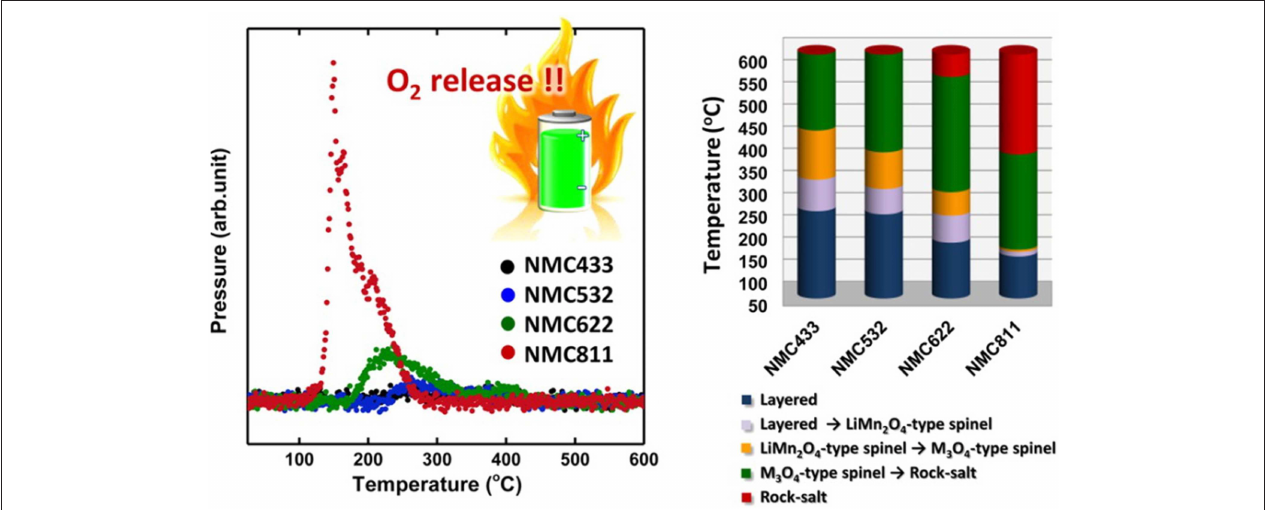
FIGURE 6 | Mass spectroscopy profiles for the oxygen (O 2 , m/z = 32) collected simultaneously during measurement of TR-XRD and the corresponding temperature region of the phase transitions for NMC. Adapted with permission from Bak et al. (2014). Copyright (2014) American Chemical